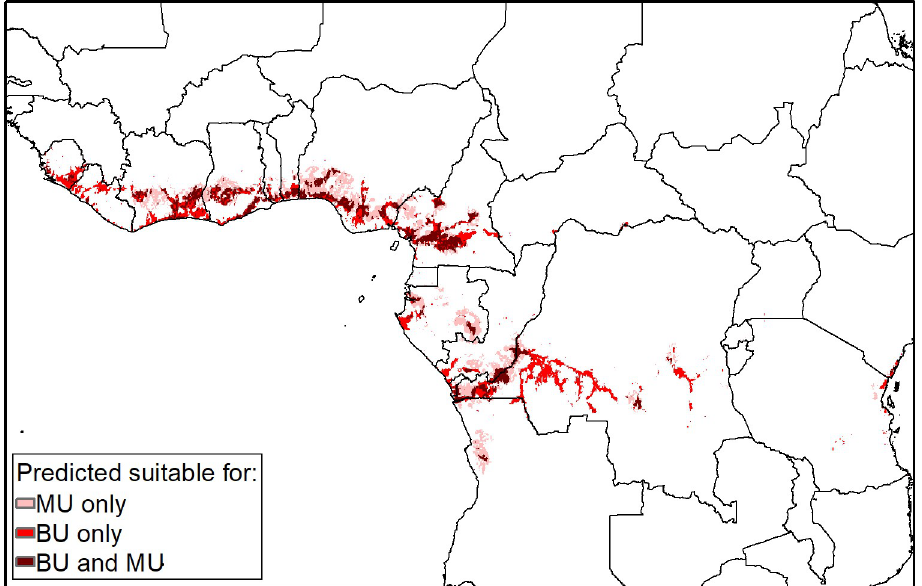
Fig 4. Predicted overlap of environmental suitability for BU and of M. ulcerans occurrence. Pink colour represents areas where Mycobacterium ulcerans (MU) is predicted to occur based on the optimal threshold of environmental suitability (0.56) but where Buruli ulcer (BU) is not predicted. Red represents areas where BU is predicted based on the optimal threshold of environmental suitability (0.51) but MU is not. Both BU and MU are predicted to occur in areas shown in dark red. All maps were produced in ArcMap 10.7 (ESRI Inc., Redlands CA, USA).